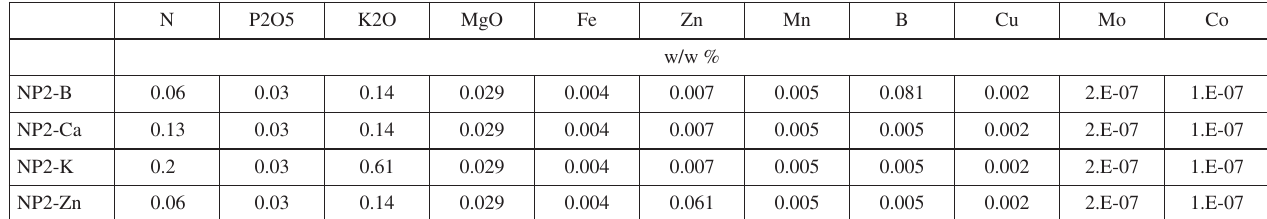
Table 1: Nutrient concentrations in NP2